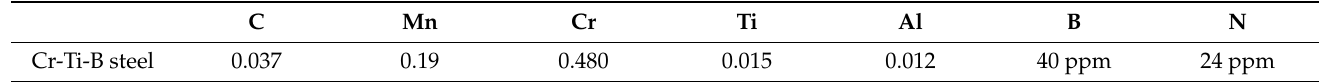
Table 1. Chemical composition of Cr-Ti-B low-carbon steel